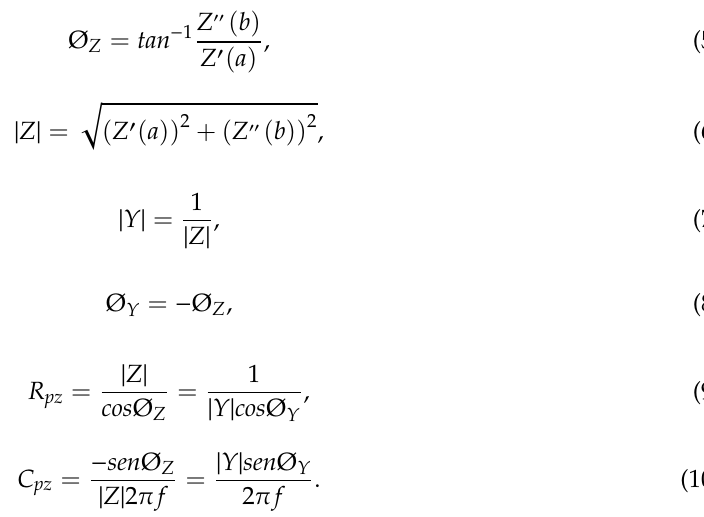
Figure 9. Fourier spectrum modulus of the measured voltage ( V o ) in the PZT ceramics.